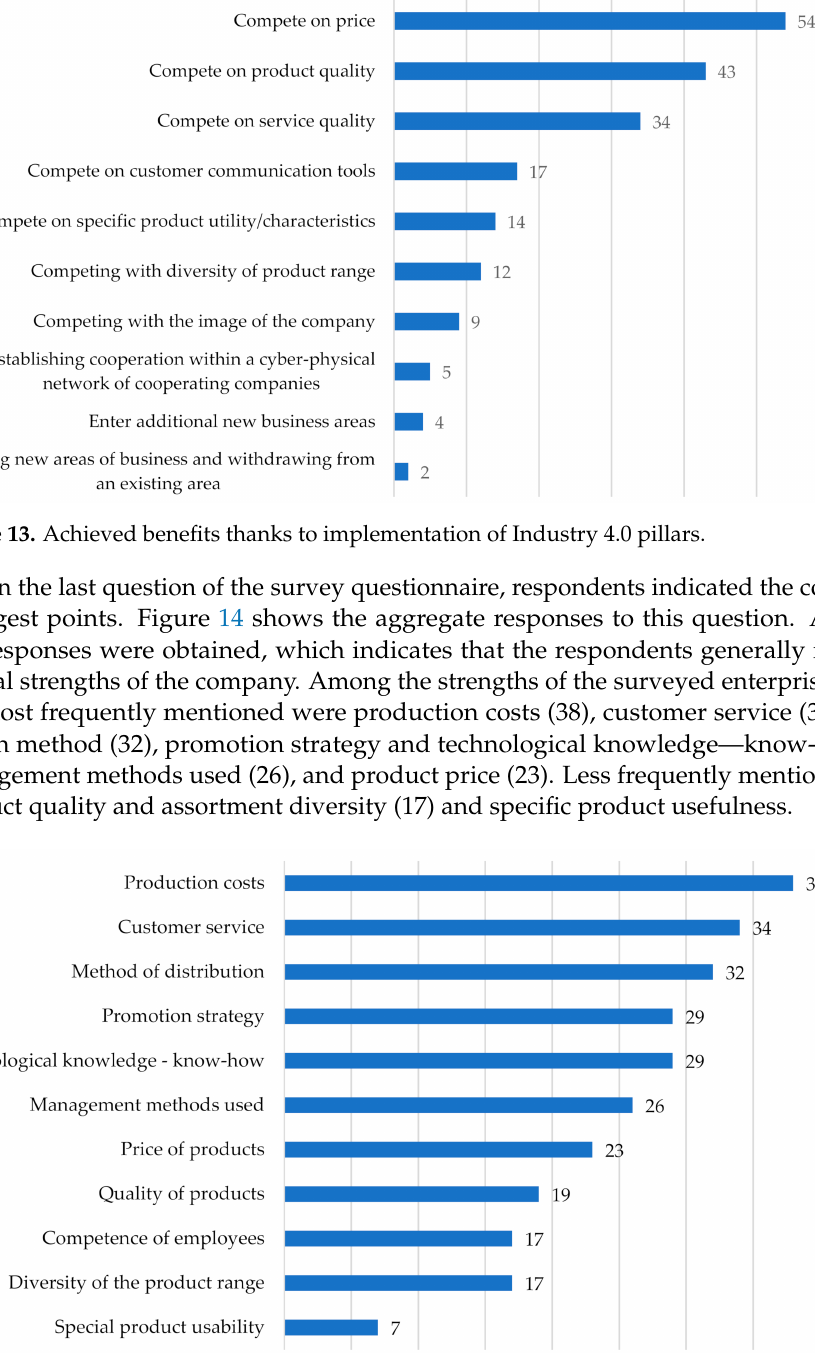
Figure 14. The company’s strongest